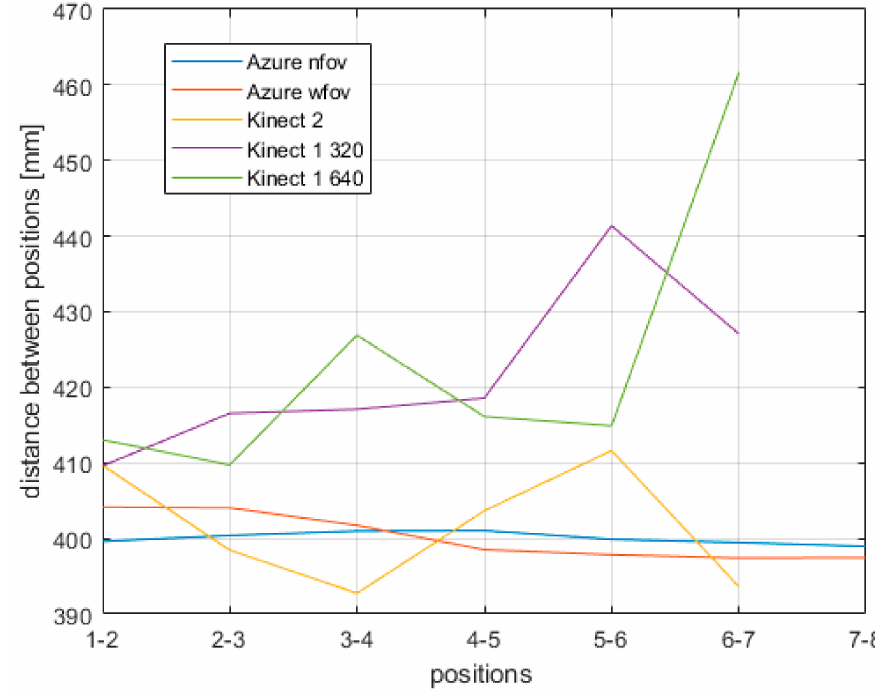
Figure 5. General accuracy measurements of all three Kinect versions.